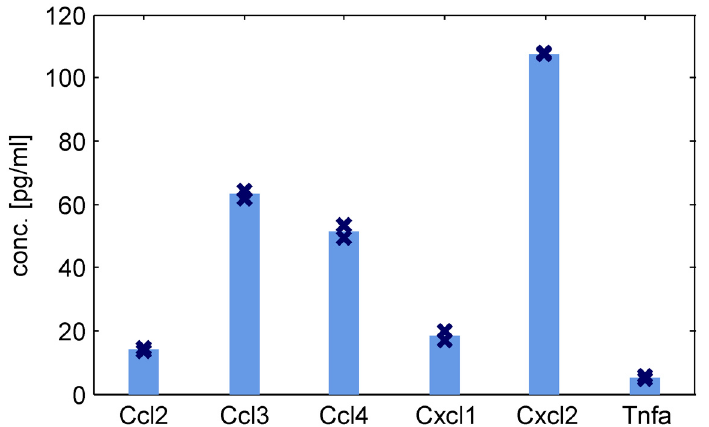
Fig 9. Proteins secreted by differentiated macrophages. Supernatant from macrophages (1 x 10 6 cells) after 3 h subcultivation in 6 well plates was analyzed via Luminex Technology. Mean levels and individual data points (n = 2) are